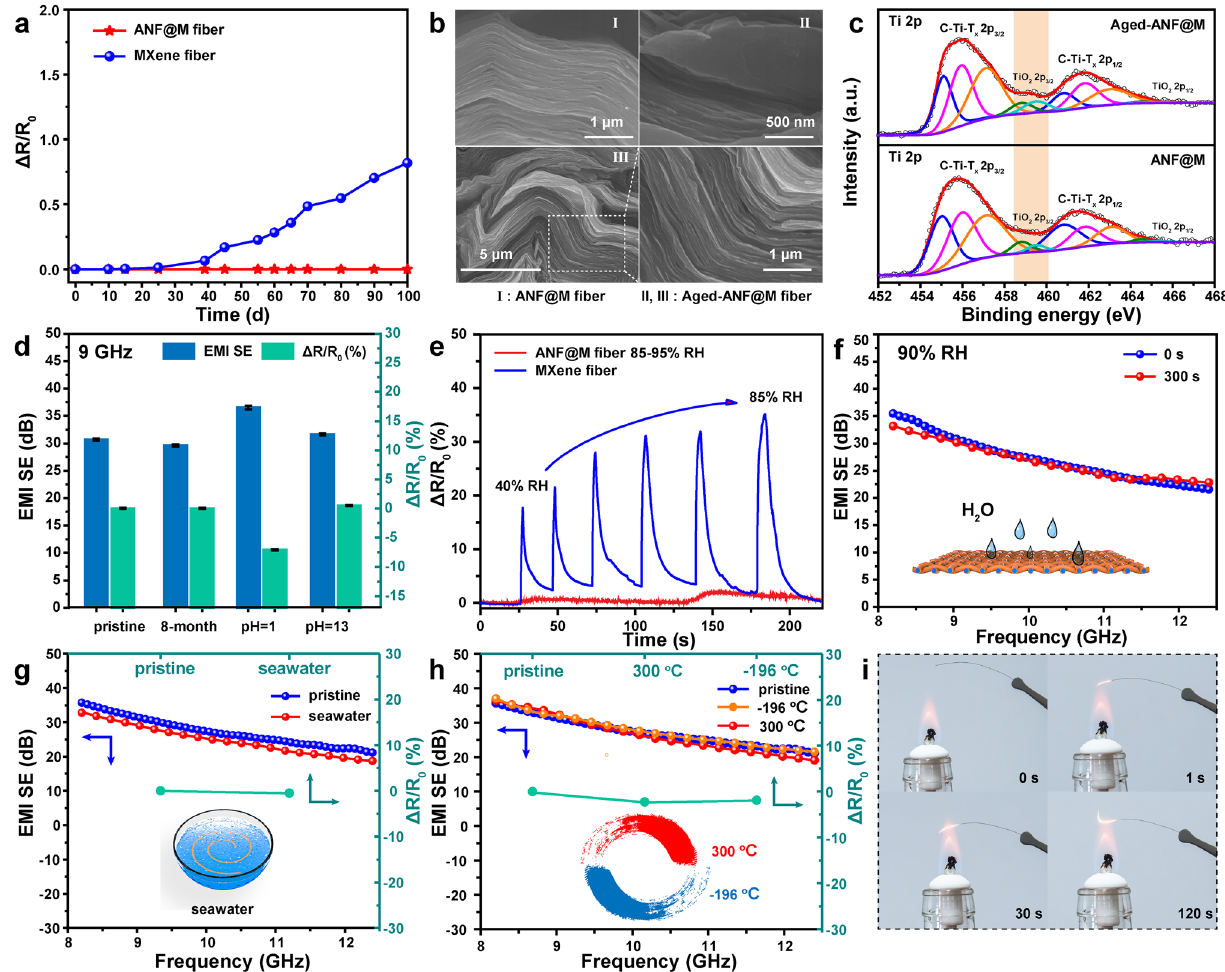
Fig. 4 a Plots of the resistance change versus time for neat MXene fiber and ANF@M fiber. b SEM images of as‑prepared ANF@M fiber (I) and after 8‑month aging (II, III), and their c Ti 2p XPS spectra. d Resistance changes and shielding performances after aging for 8‑month, and in acid and alkali solutions for 20 h. e Humidity‑dependent resistance changes of neat MXene fiber and ANF@M fiber. EMI shielding perfor‑ mances of ANF@M fiber f under a relative humidity of 90%, and g in seawater. h Resistance changes of ANF@M fiber at different temperatures and shielding performances of the ANF@M fiber treated at different temperatures. i Non‑flammability of the ANF@M fiber in